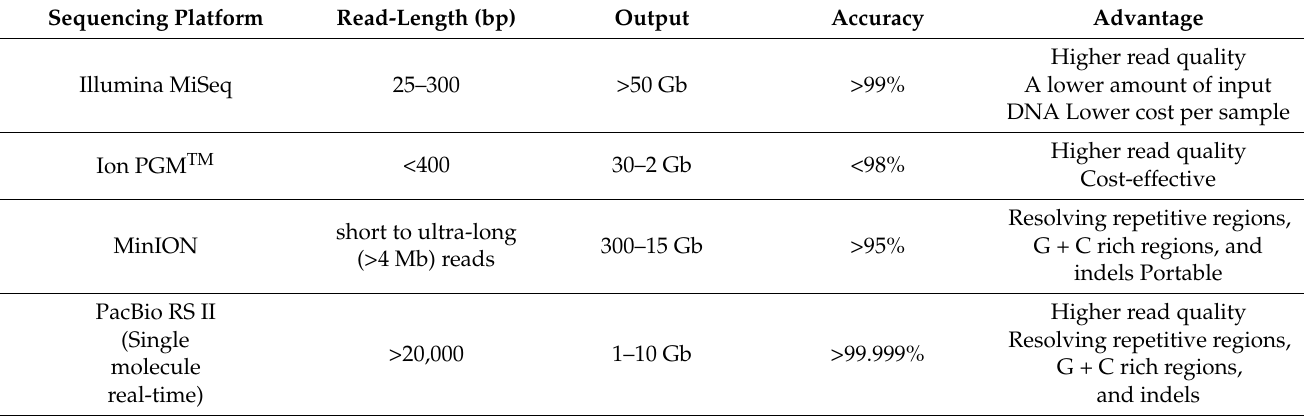
Table 1. Comparison of basic sequencing platforms used for complete genome assemblies of new NTM species. Sequencing